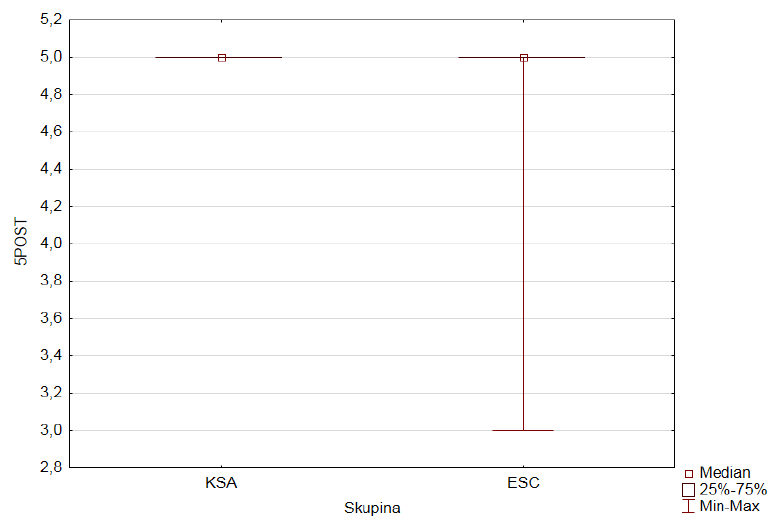
Figure 6. The box graph of the fifth item of the posttest - 5POST.